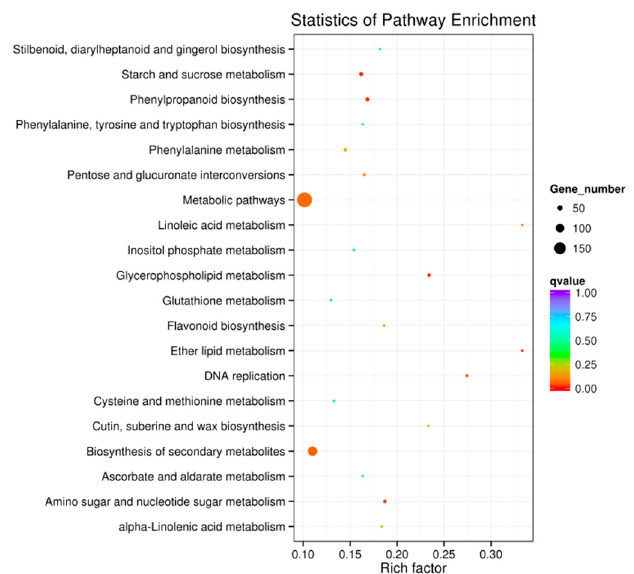
Figure 4. Statistics of Kyoto Encyclopedia of Genes and Genomes (KEGG) pathway enrichment analysis of DEGs between NT and MHT exposed tobacco leaves. KEGG pathways are plotted on the ordinate, and the enrichment factor (rich factor) is plotted on the abscissa. The color of points represents the q-value, and the size of points represents the number of DEGs mapped to the reference pathway. Legends for the color scale of q-values and size-scaling of the number of DEGs are shown to the right of the plot.